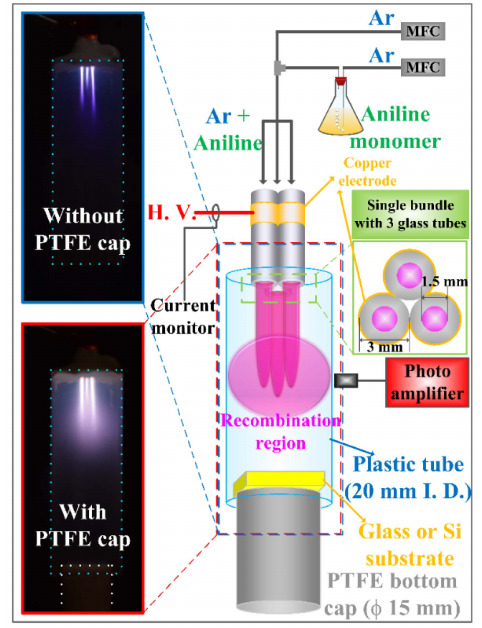
Figure 1. Schematic diagram of experimental setup in this study and images of plasmas produced in the recombination region of intense plasma cloud type atmospheric pressure plasma jets (iPC-APPJ), with and without the polytetrafluoroethylene (PTFE) bottom